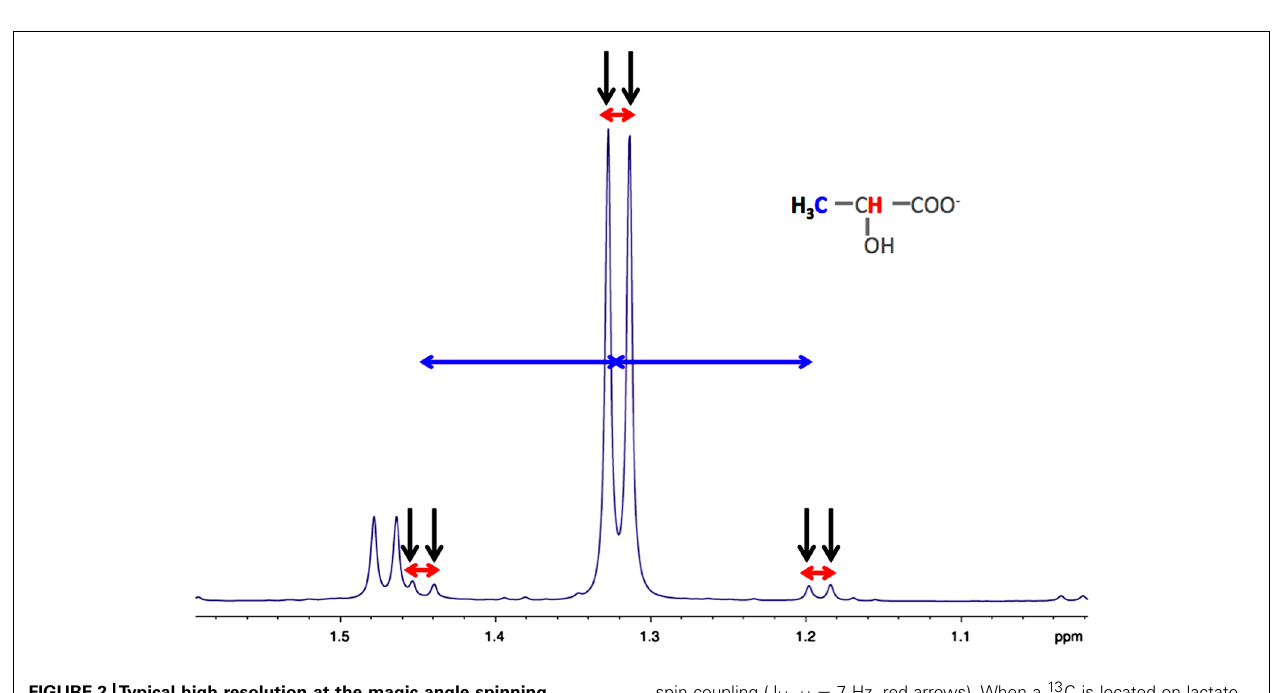
spin coupling (J H − H = 7 Hz, red arrows). When a 13 C is located on lactate carbon 3, then a doublet of doublet is appearing ( 13 C satellites of H 3 lactate), due to the heteronuclear spin coupling (J H − C = 128 Hz, horizontal blue